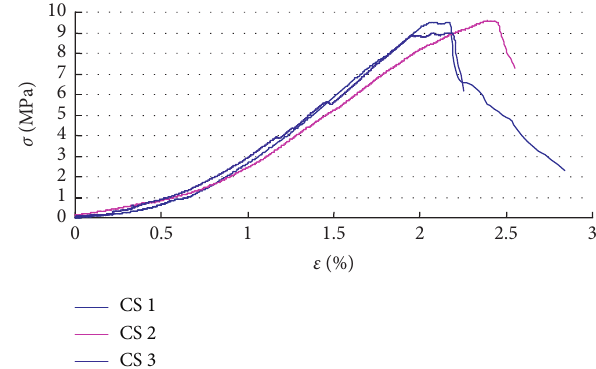
Figure 15: Variation in gas flow with increasing temperature at a gas pressure of 1MPa. Figure 16: Stress-strain curves of coal samples (CS) compressed under no-gas conditions.